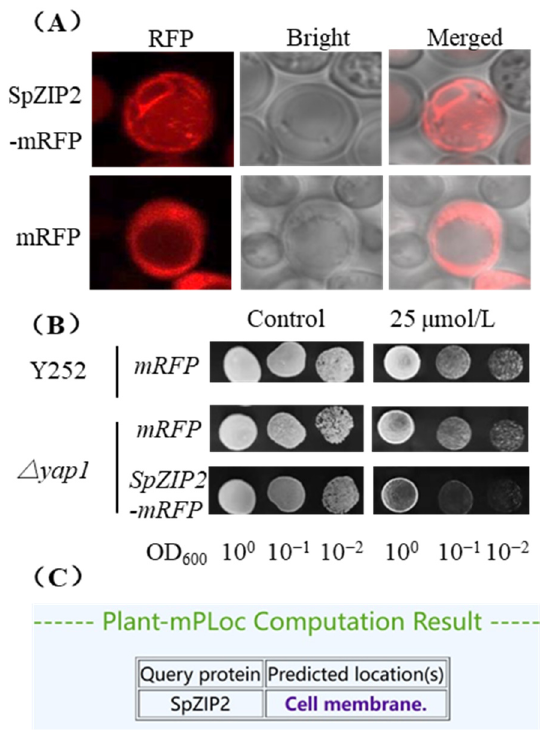
Figure 7. Subcellular localization analysis of SpZIP2. ( A ) Subcellular localization of SpZIP2-mRFP fusion proteins or mRFP in yeast Δ yap1. ( B ) Tolerance of yeast transformants expressing SpZIP2-mRFP to Cd stress. ( C ) Subcellular localization prediction for SpZIP2 by Plant-mPLoc.